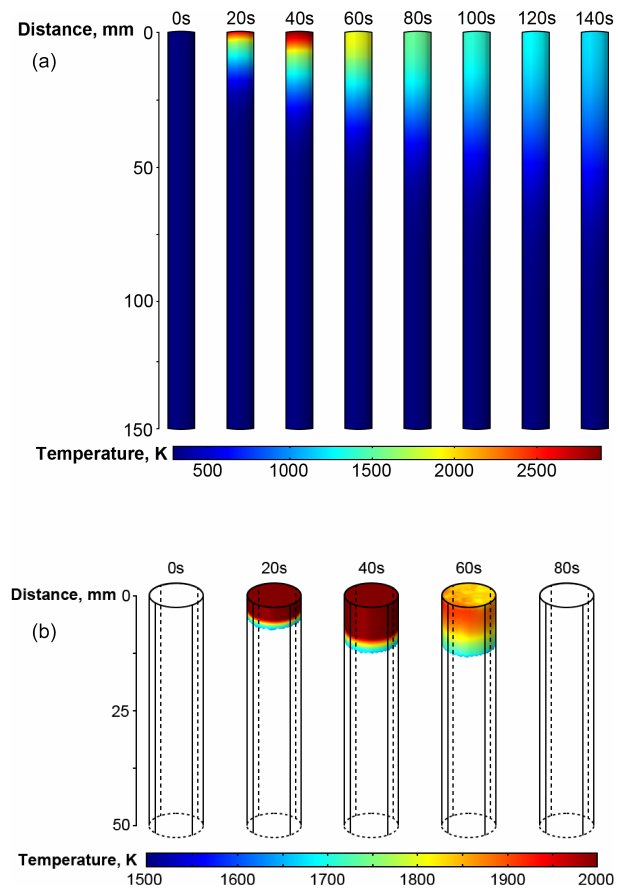
Figure 11. (a) Temperature distribution along the length of the cylindrical rod. (b) The melt pool depth in